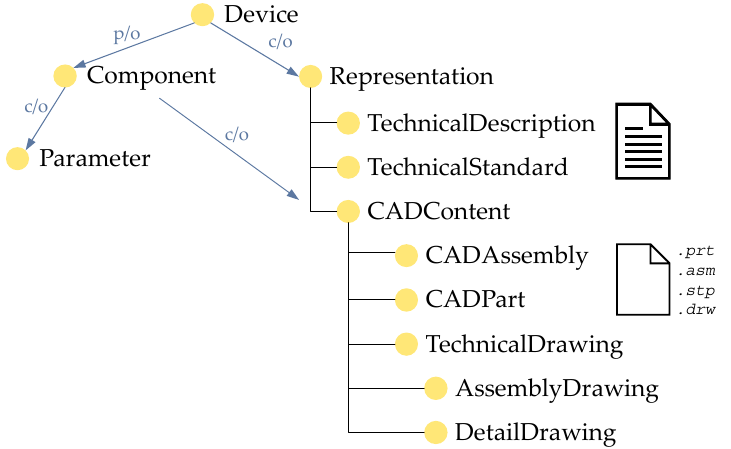
Figure 8. Integration of information about the device used in experiments.